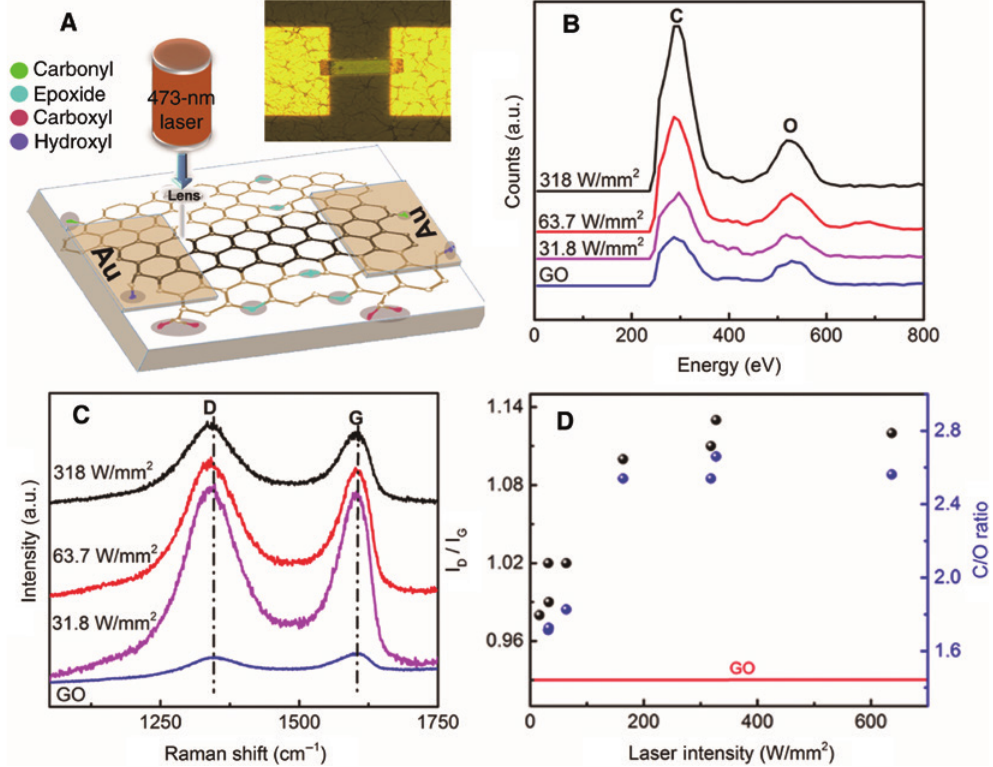
Figure 1: Characterization for laser rGO films. (A) Schematic view of the laser-scribed devices. Brown hexagons decorated with oxygen-containing groups denote GO, whereas the black channel between two Au electrodes represents rGO. The inset is a photograph of a PSD device. (B) EDX spectra of GO and rGO films after reduction with different laser intensities. (C) Raman spectra of GO and rGO with different laser reduction intensities. (D) Dependence of I (black points) and C/O ratios (blue points) on the laser intensity. The red line is the I